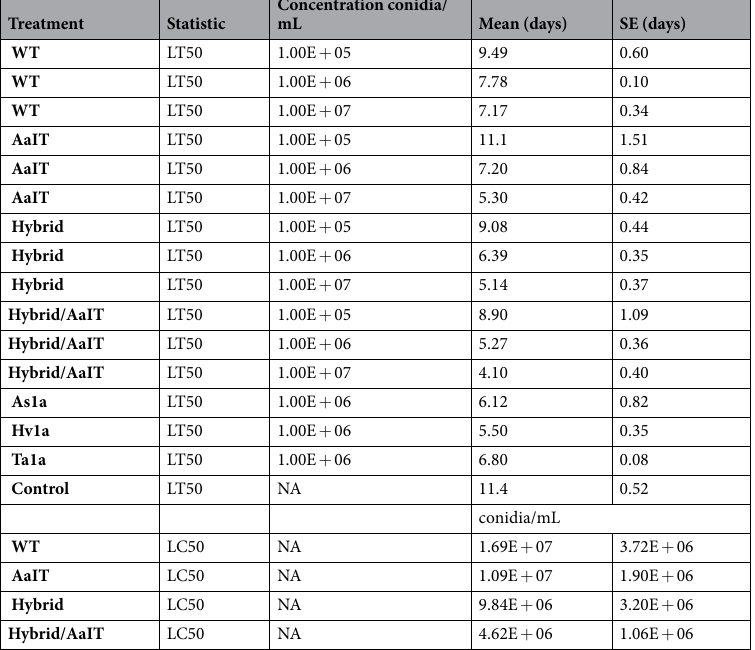
Table 1. LT50s and LC50s (day 5) for Anopheles gambiae treated with Metarhizium pingshaense strains expressing arthropod-derived toxins alone and stacked (Hybrid/AaIT) compared with wild-type (WT) and a control (0.01% Tween). Mean and standard error is reported across three